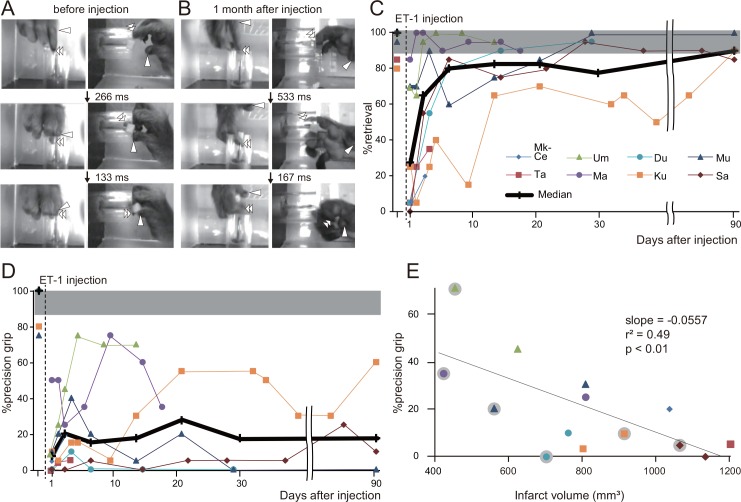
Behavioral changes after endothelin-1 (ET-1) injection.(A, B) Sequence of photographs showing hand and digit movements of a macaque (Mk-Du) performing the small-object retrieval task before (A) and at 1 month after (B) ET-1 injection. Upper, middle, and lower rows show both top and side views at the moments when the macaque inserts the index finger through the aperture of the cylindrical tube; when the tip of the index finger contacts the food morsel; and when the macaque pulls the index finger out of the tube, respectively. Arrowhead, thumb tip; double arrowheads, index finger tip. Before ET-1 injection, use of the precision grip involving the tips of both the index finger and the thumb was observed in almost all trials. At 1 month after injection, the macaque raked out the food morsel with the index finger and then held it in the proximal joints of the thumb. (C, D) Time course of changes in the percentage of successful retrieval (C) and precision grip (D) in all of ET-1-injected macaques. Shaded gray region represents the 95% confidence interval for performance before injection. The number of successful retrievals progressively increased over the first week; by 3 months after injection, it had reached the 95% confidence level. The median value for precision grip increased gradually in the first 3 weeks after injection; it then virtually plateaued and at 3 months was still below the 95% confidence level. (E) Correlation between infarct volume and successful achievement of precision grip 3 days or 1 week after ET-1 injection. Each symbol represents data from one macaque; symbols without gray circles are data for 3 days after injection, whereas symbols with gray circles are those for 1 week after injection. The success rate in achieving a precision grip at 3 days or 1 week was negatively correlated with the infarct volume.